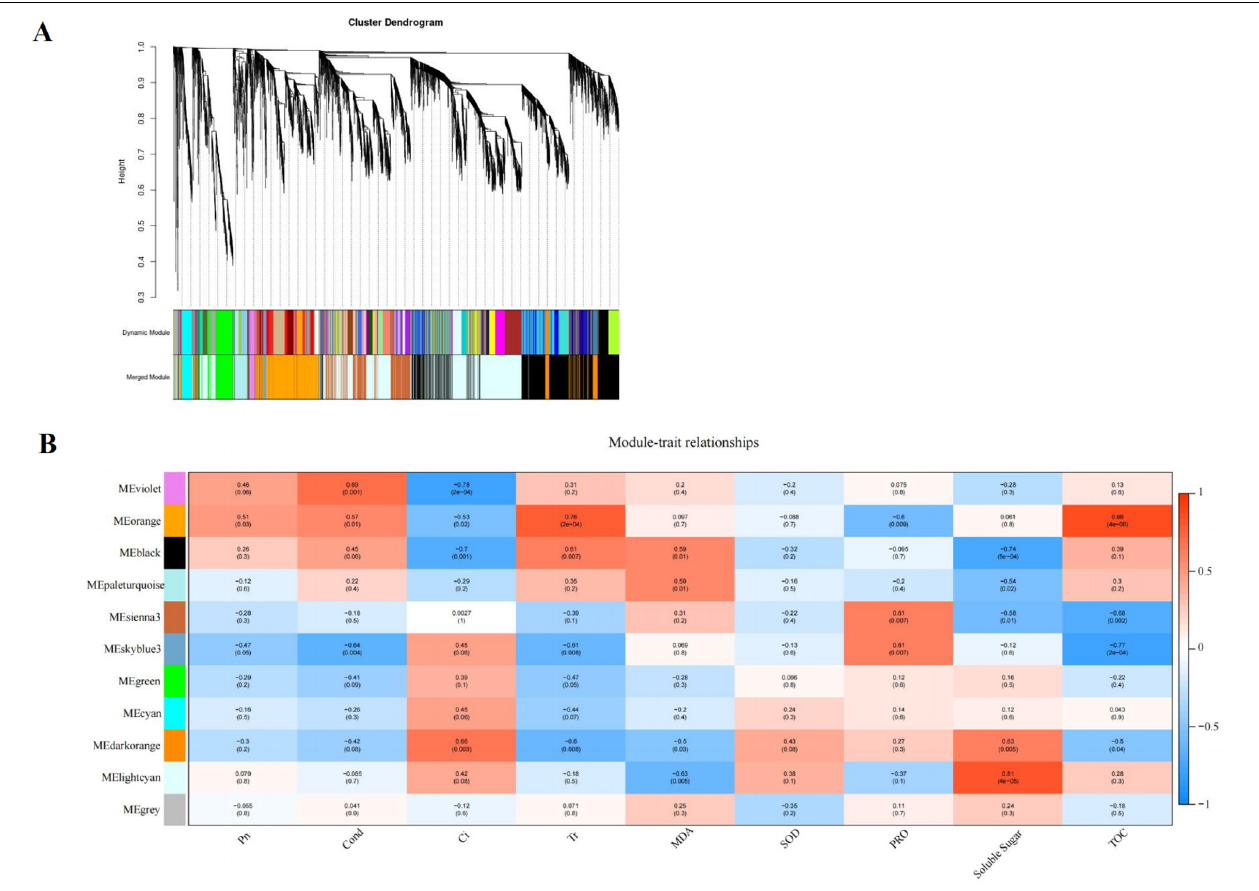
FIGURE 7 | Cluster hierarchy of 24 co-expression modules divided by co-expression network (A) ; Identification of pathway modules related to photosynthesis and cold tolerance indexes (B) . The correlation coefficient between the module and sample is described by the color of each cell at the row-column intersection. Red and blue colors indicate the positive and negative correlations,